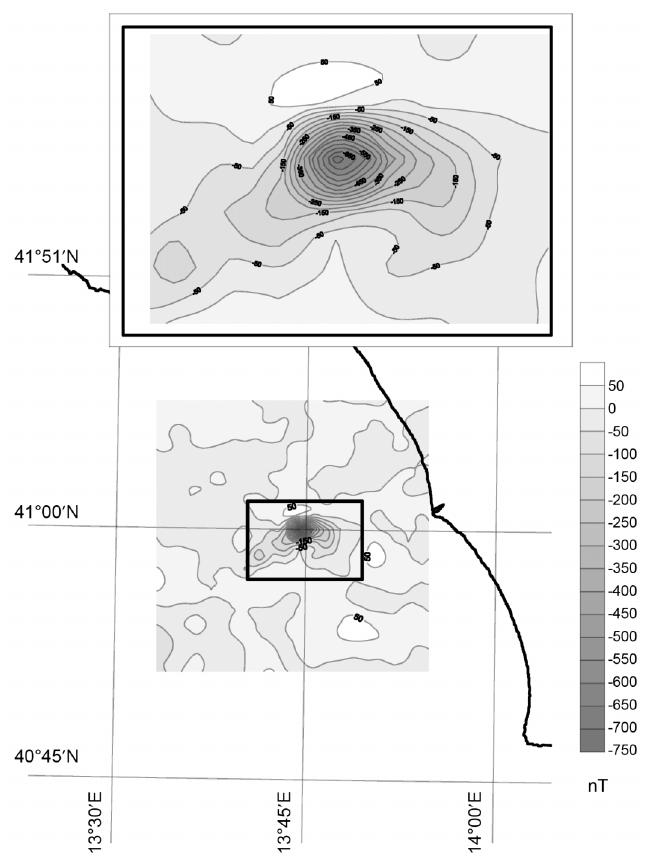
Fig. 8. De-trended ship-borne anomaly obtained with the application of the wavelet transform, separated from the long period gradient across 41°N; compare to fig. 6. The outlined field is zoomed in the upper